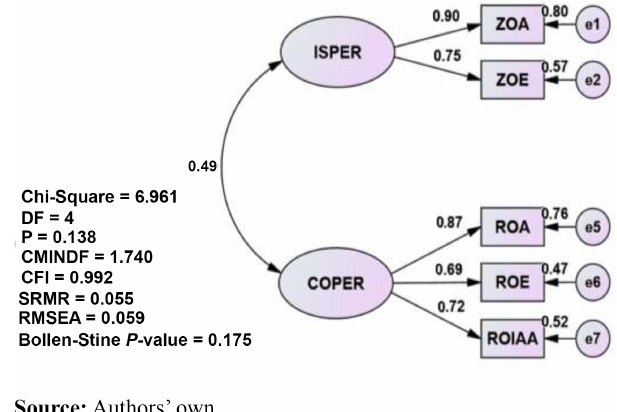
Figure 6. CFA model of multi- bank performance (ISPER